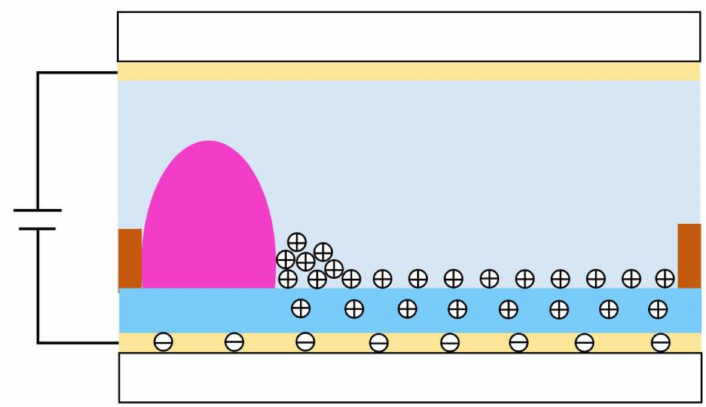
Figure 3. The phenomenon of charge trapping. Part of charge is trapped in the insulating layer when a voltage is applied between two ITO electrodes, resulting in the formation of a reverse electric field. The charge trapping phenomenon occurred when trapped charges cannot be released